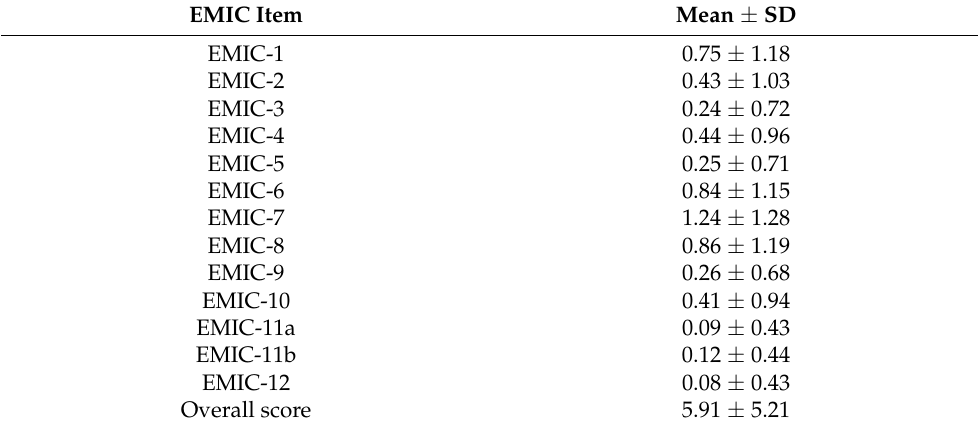
Table 2. Mean scores of EMIC items.